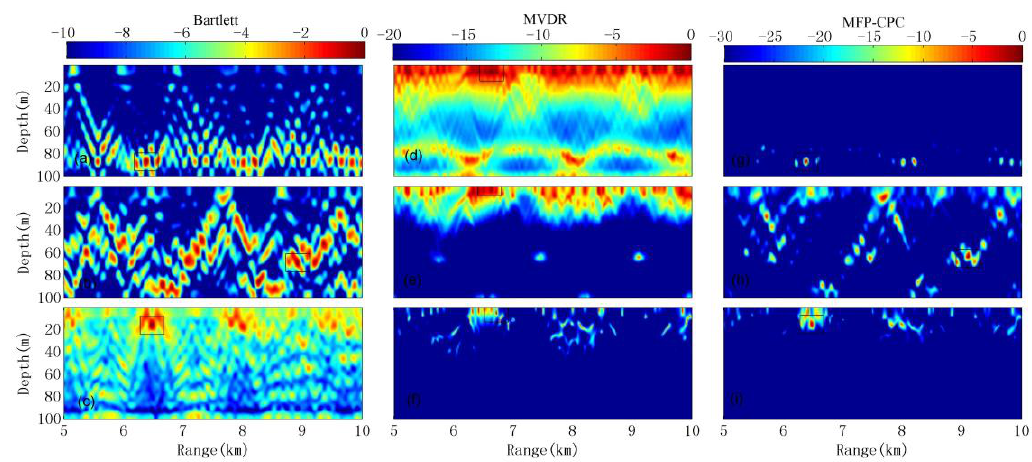
Figure 5. Localization results for the three MFP methods under GENLMIS environment model.